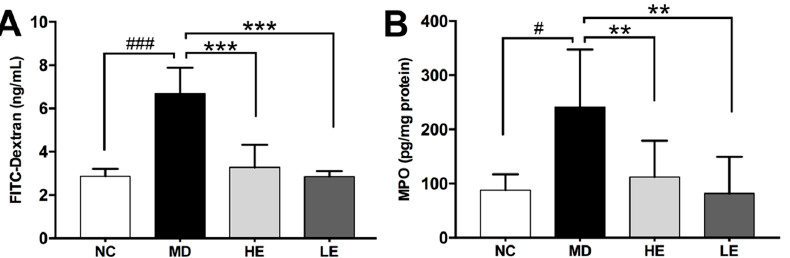
Figure 4. Effect of EGCG treatment on intestinal permeability ( A ), and myeloperoxidase (MPO) levels ( B ) in DSS-induced colitis. Intestinal permeability was measured using the fluorescein isothiocyanate conjugated dextran (FITC-dextran) assay on Day 12. At the end of the study, the colon was harvested and divided equally into three parts. MPO levels in the distal part of the colonic tissue was measured as a marker of neutrophil infiltration. DSS treatment significantly increased serum FITC-dextran levels and colon tissue MPO levels. Both high-and low-dose EGCG treatment decreased serum FITC-dextran levels and colonic tissue MPO levels significantly. FITC-dextran: Fluorescein isothiocyanate conjugated dextran, MPO: Myeloperoxidase; NC: Normal control group, MD: Colitis model group, HE: High-dose EGCG group, LE: Low-dose EGCG group. Data are presented as mean ± standard deviation. ** p < 0.01 vs. MD, *** p < 0.001 vs. MD, # p < 0.05 vs. NC, ### p < 0.001 vs. NC. Nutrients 2019 , 11 , x FOR PEER REVIEW